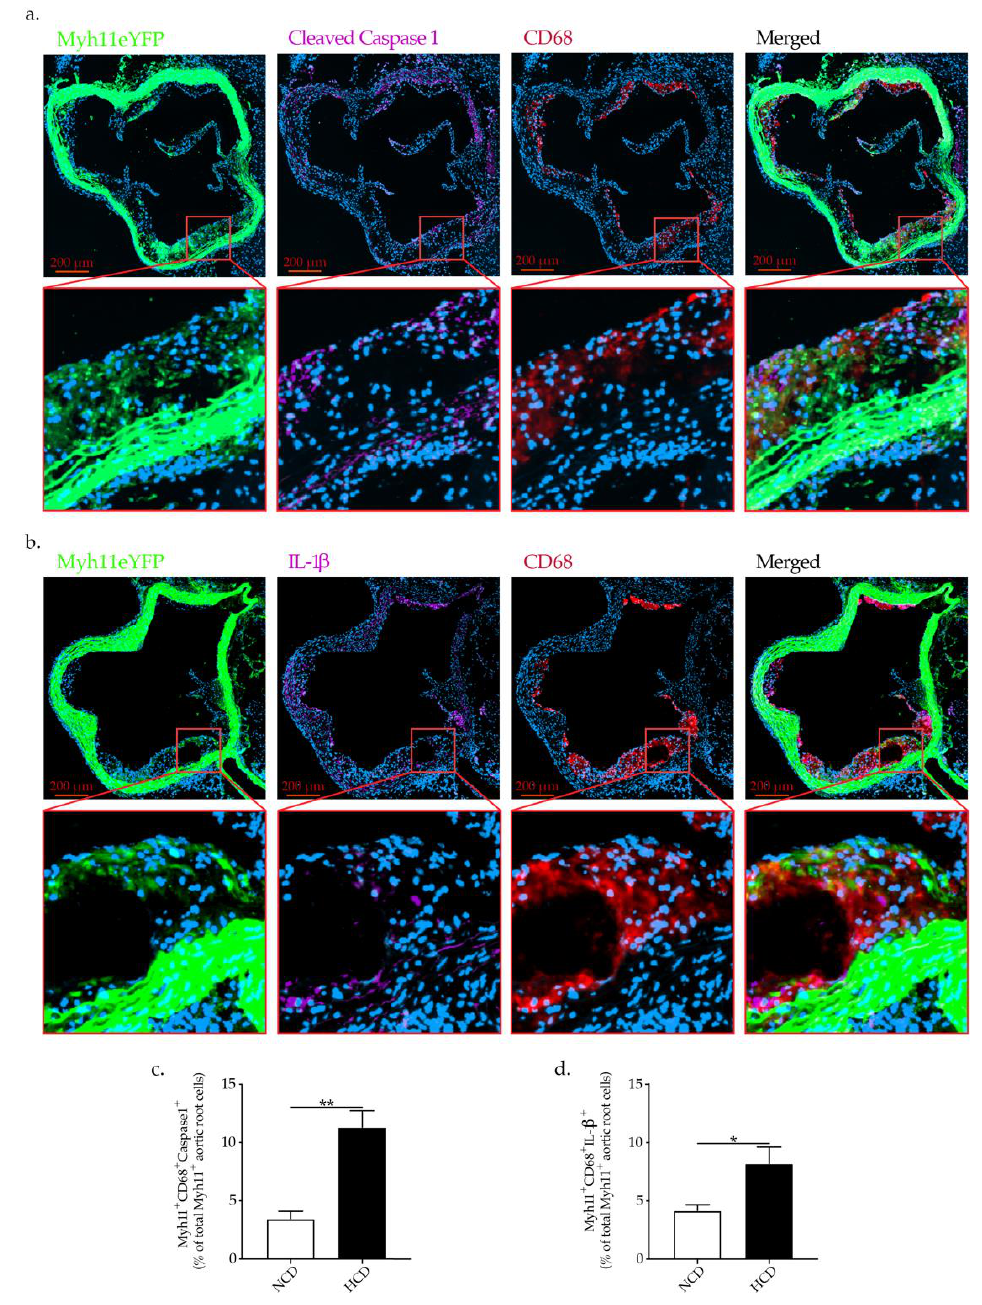
Figure 7. Representative immunofluorescence staining of Myh11eYFP + cells, expressing ( a ) cleaved caspase 1, CD68 and ( b ) IL-1 β , CD68 in the aortic roots of Apoe − / − Myh11ERT2-CreR26R-eYFP mice showing NLRP3 inflammasome activation in VSMC undergoing phenotypic switch in vivo, taken by confocal microscopy (LSM 800 Airyscan). Graph bars show the mean ± SEM of ( c ) Myh11eYFP + CD68 + Cleaved Caspase1 + and ( d ). Myh11eYFP + CD68 + IL-1 β co-expressing cells as a percentage of all Myh11eYFP + cells in the aortic roots plaquesm with n = 8/group and * p < 0.05, ** p < 0.01, unpaired t -test.